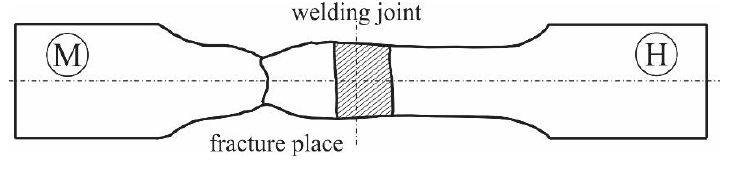
Figure 12 – Test tube 2.1 after tearing Рис. 12 – Эпроветка 2.1 после разрыва Слика 12 – Епрувета 2.1 након